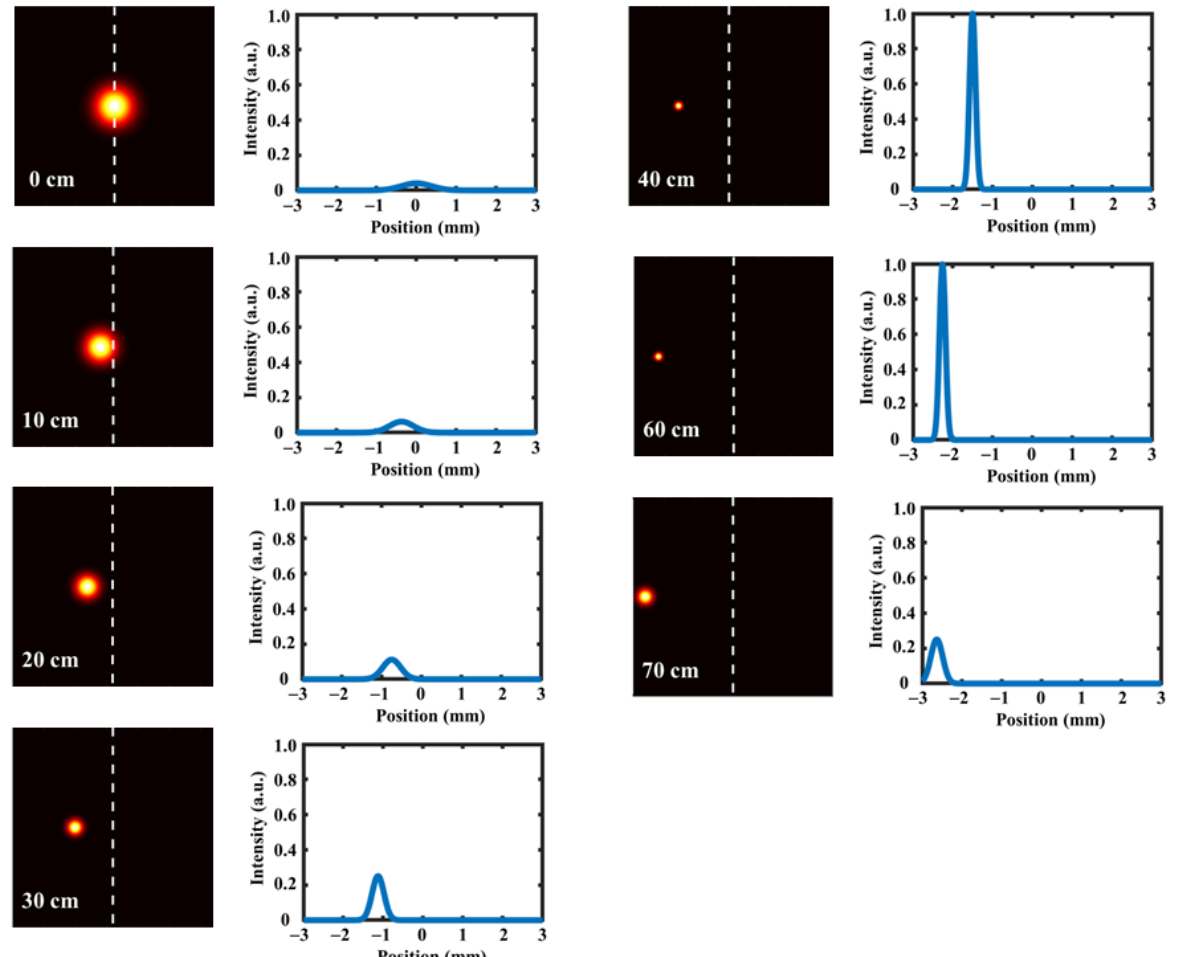
Figure 6. Simulation results of the light field and corresponding intensity distribution captured at different positions away from the compound FLC lens with left-handed circularly polarized input light.